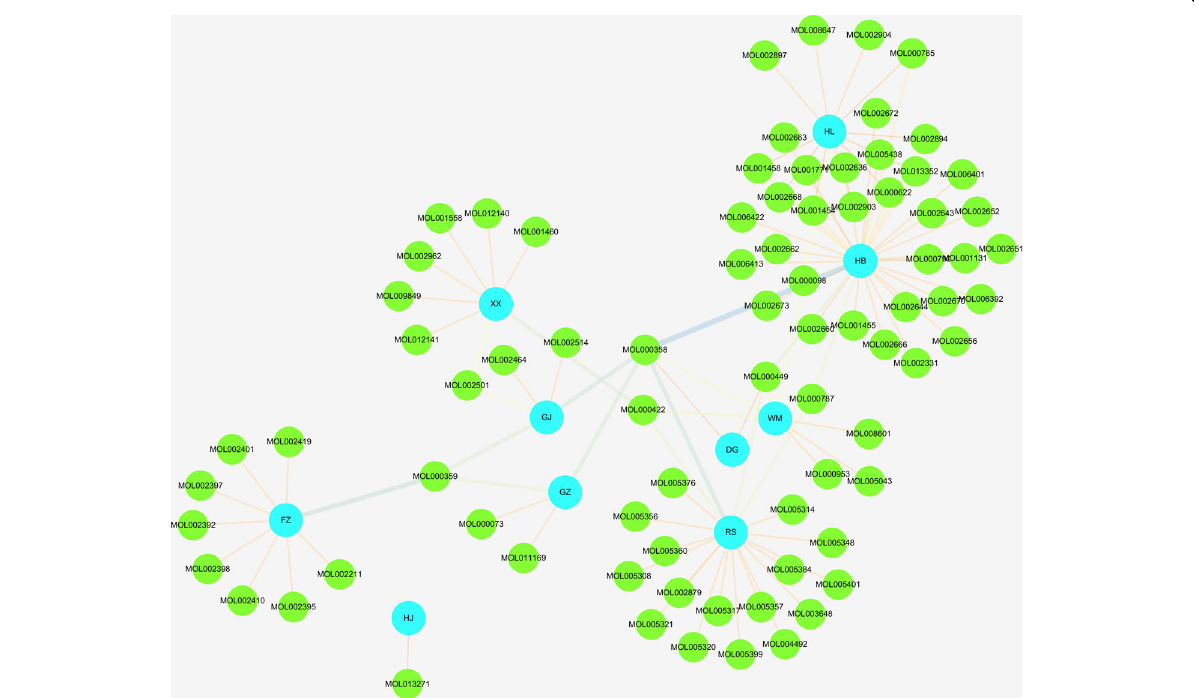
Fig. 2 Herbs-Compounds network. The blue nodes represent herbs in Wumei Pill, and the green nodes represent active compounds. The edges represent the relationship between them, and the length, width and color of the edges is proportional to the edge betweenness